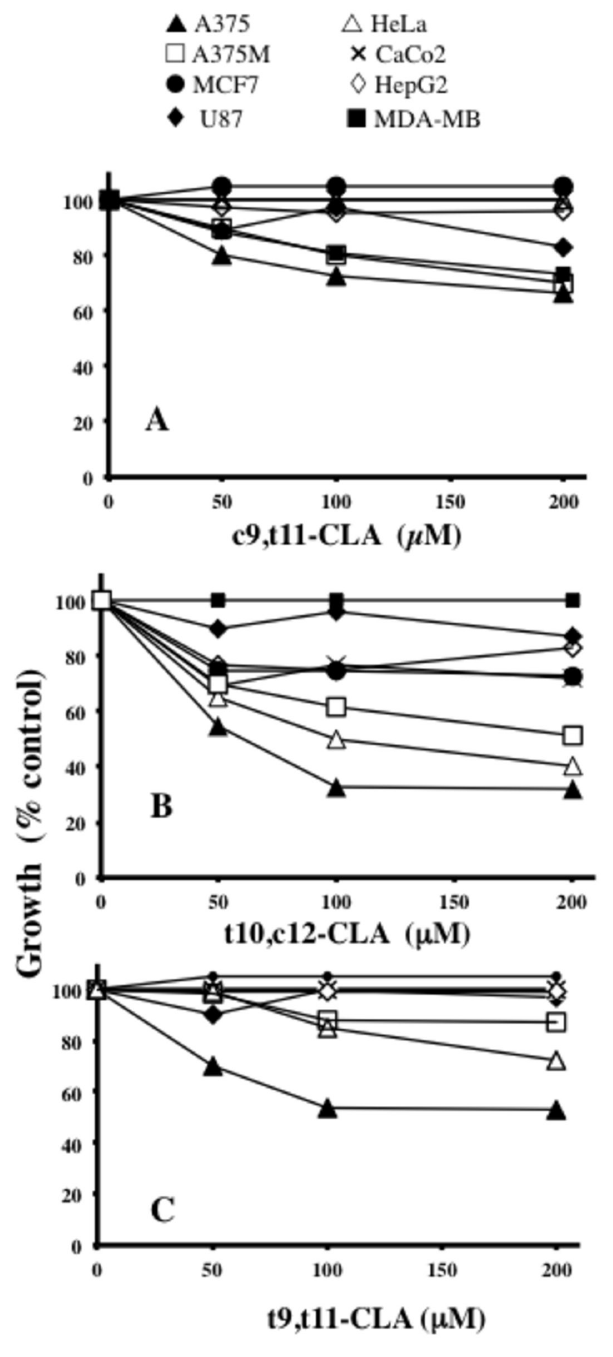
Figure 3. Human cancer cells exhibit differential sensitivity to the anti-proliferative activity of CLA isomers. The effects of c9,t11 (A), t10,c12- (B) or t9,t11-CLA isomers (C) on cell viability were assessed in eight cancer cell lines exposed for 24h to increasing concentrations of the CLA isomers. Data are expressed as means ±SD values of triplicate data from three independent experiments. SD values lower than 5% were not